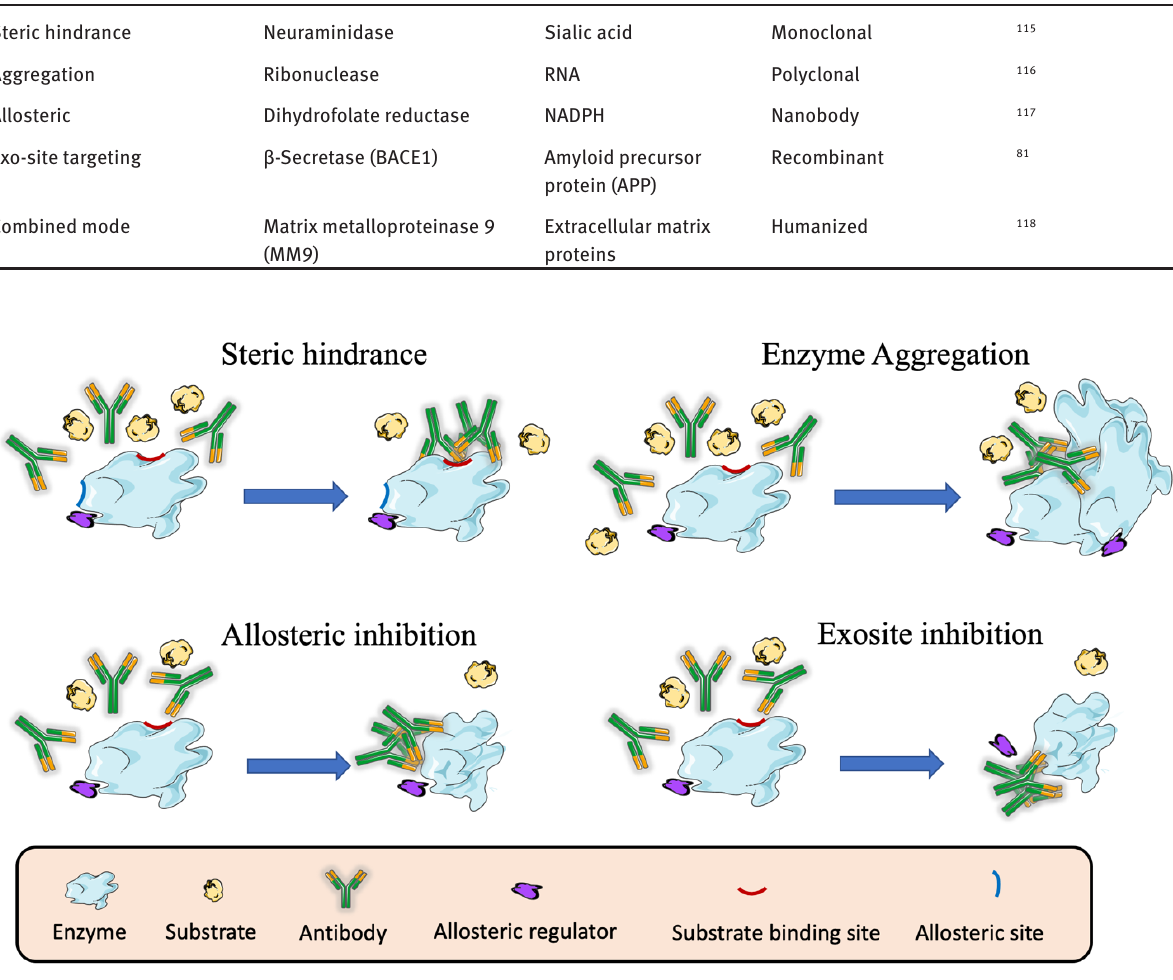
Figure 2 : Different mechanisms of enzyme inhibition by